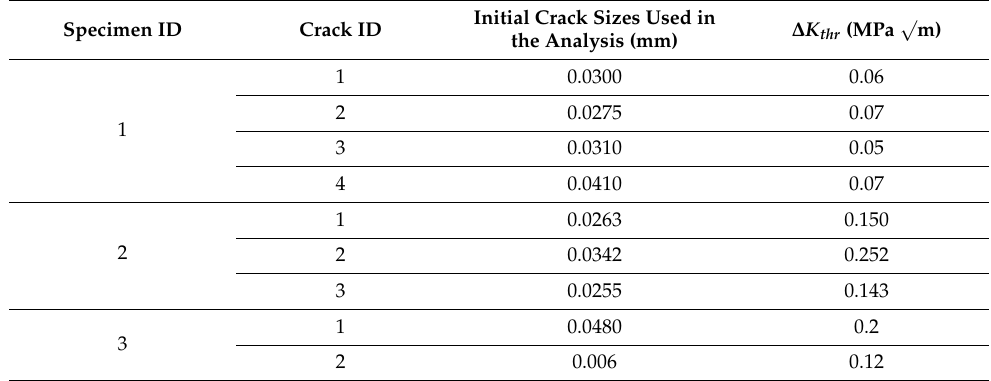
√ m) used in the crack growth analyses.